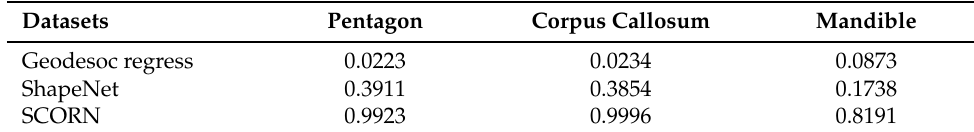
Table 4. R 2 statistic of predicting data.